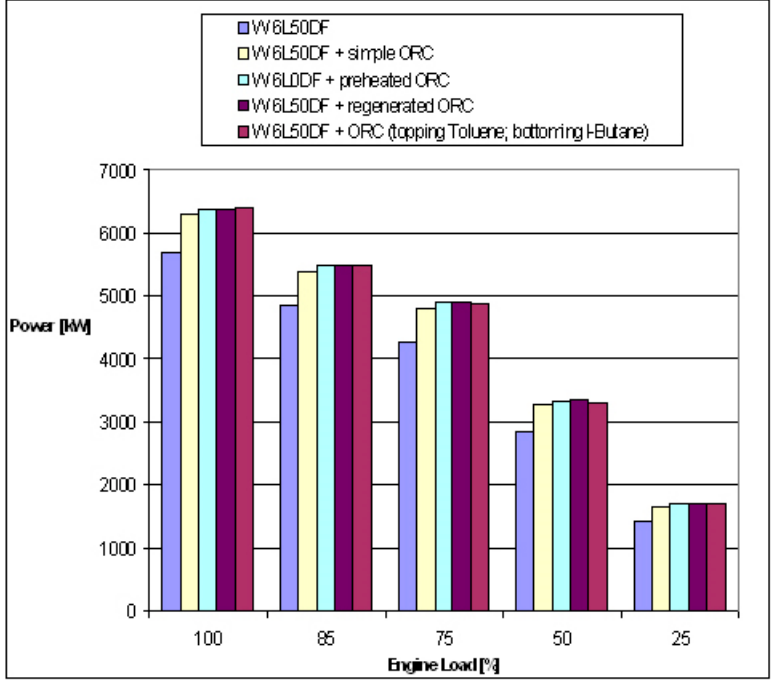
Figure 10. Power of the combined propulsion system, according to the load, for the different cycle configurations studied.